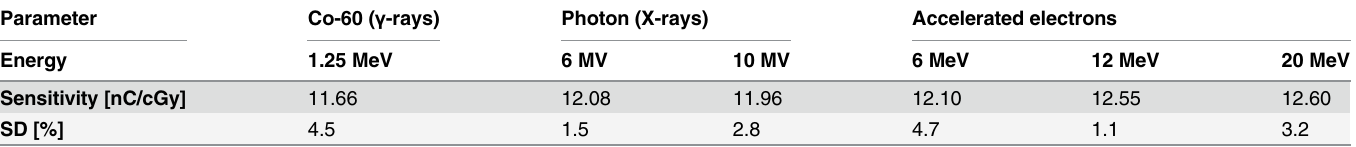
Table 5. Dependency on energy for fibre of 42 μ m core size.